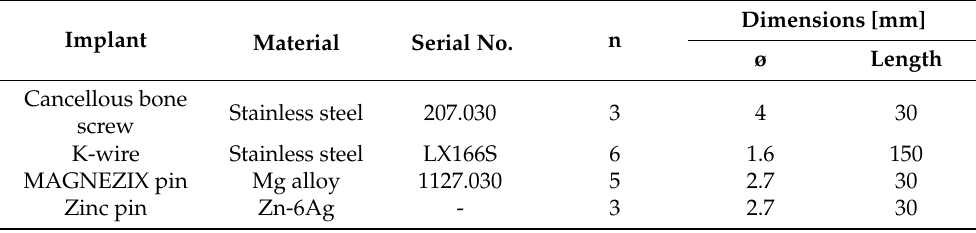
Table 1. This table lists the implants, their number, and dimensions used for shear